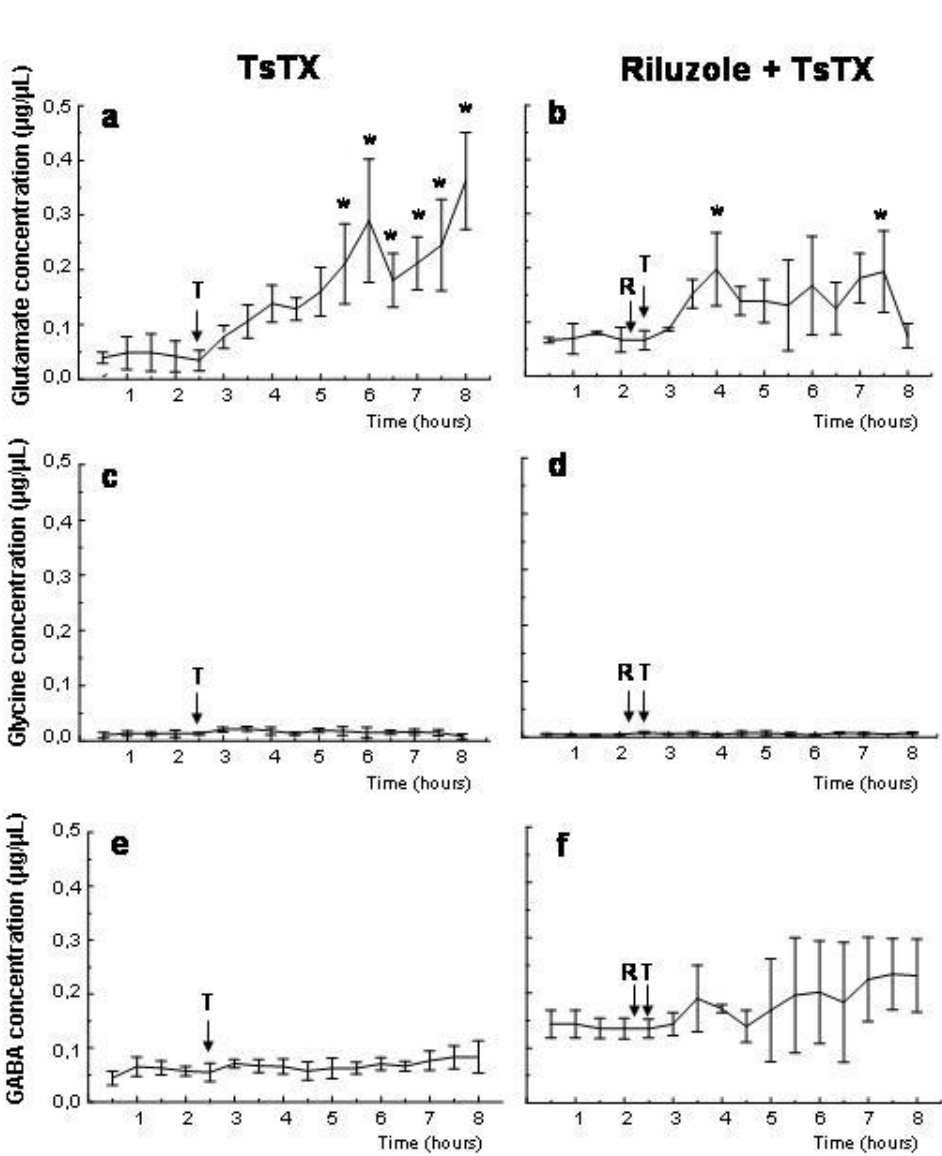
Figure 2. Extracellular levels of hippocampal glutamate ( a ), glycine ( c ), and GABA ( e ) determined by microdialysis in conscious rats before and after ipsilateral intrahippocampal injection of 2 µg TsTX. Panels on the right ( b , d , f ) show the effect of pretreatment with riluzole (5 mg/kg IP) on the response to toxin intrahippocampal injection. Arrows indicate time of riluzole (R) and toxin (T) injection. Error bars show standard deviation p < 0.05 compared to pre-injection level, one-way repeated measures ANOVA and Tukey’s test. All groups n =